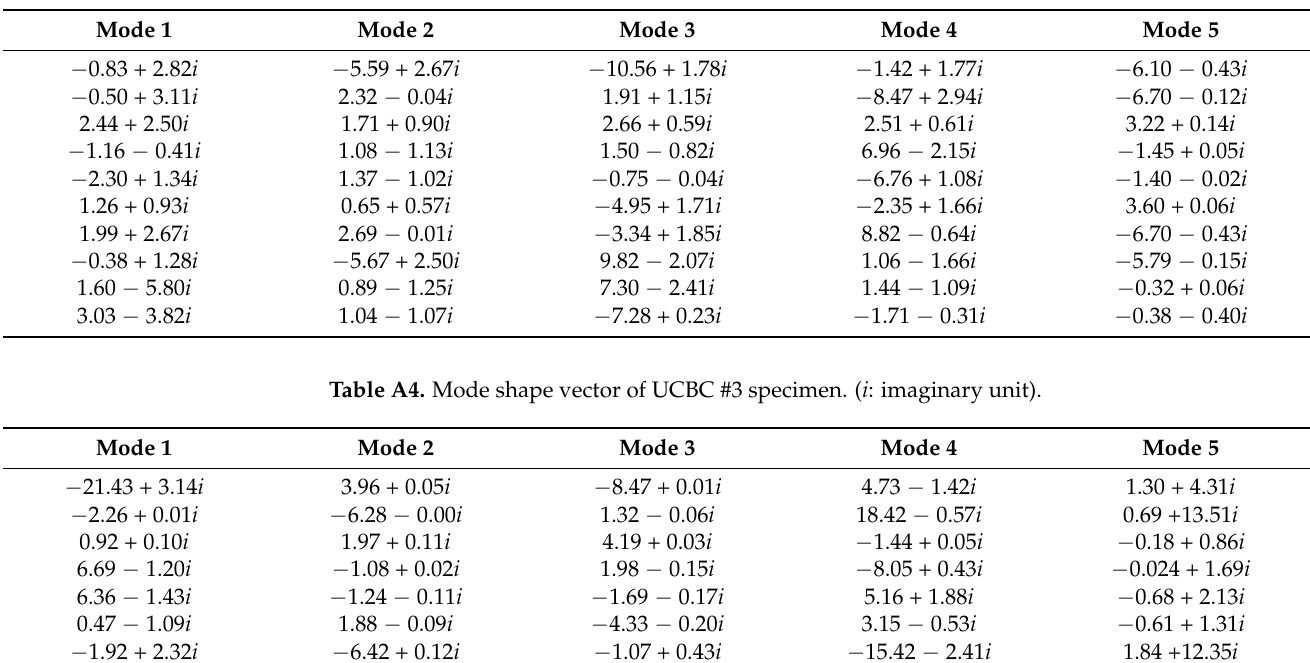
Table A3. Mode shape vector of UCBC #2 specimen. ( i : imaginary unit).